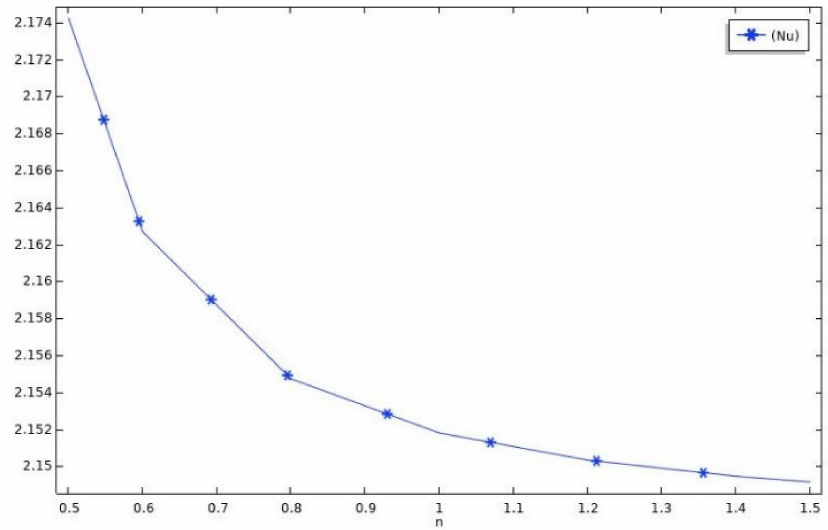
Figure 8. Cutlines for varying Rayleigh number ( Ra ) ( a ) Cutlines for varying Ra at x = 0.3, ( b ) Cutlines for varying Ra at x = 0.5, ( c ) Cutlines for varying Ra at x = 0.8.